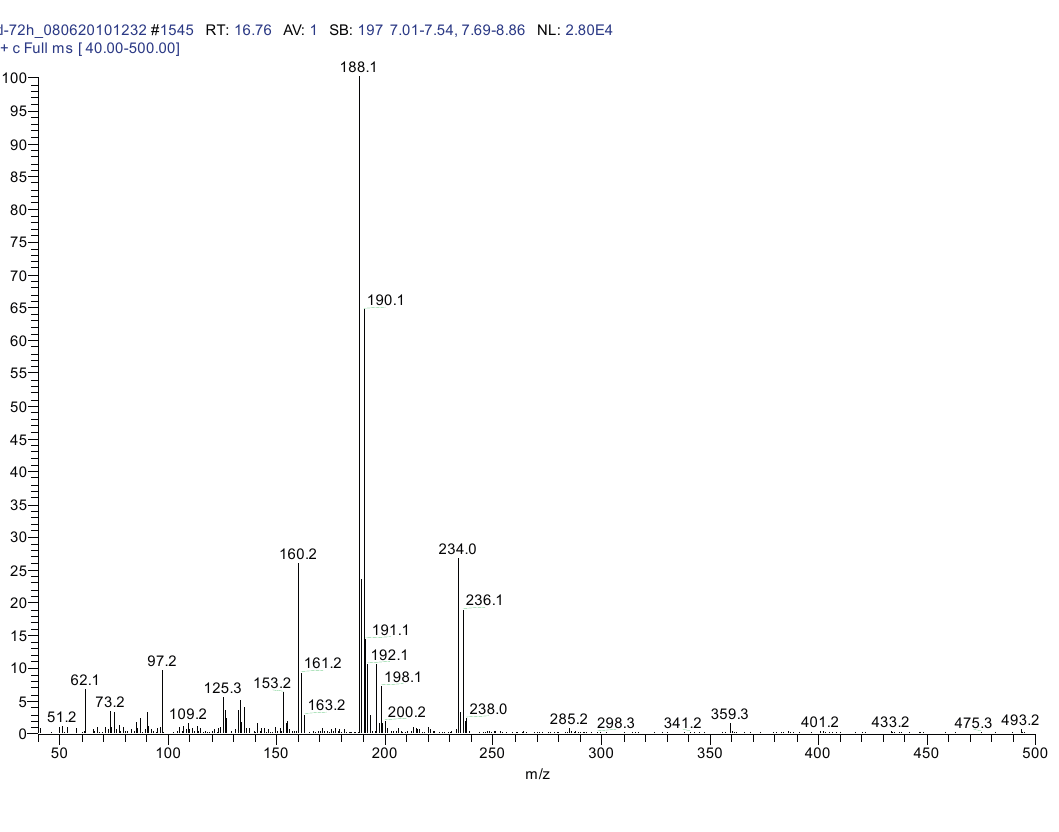
Figure 6. MS spectrum of chlorinated salicylic acid.